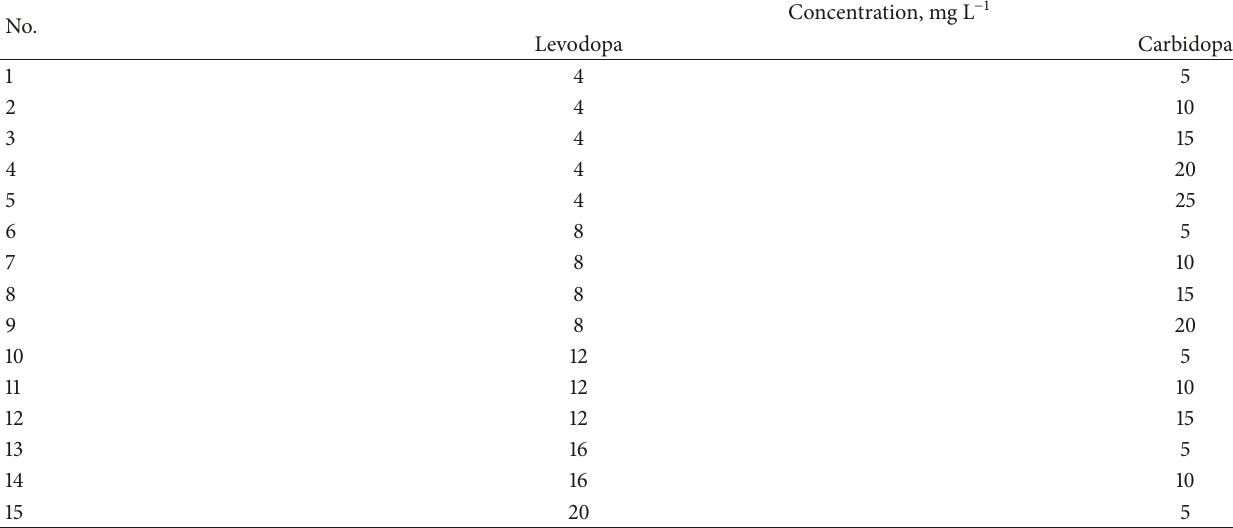
Table 1: Concentration set for levodopa and carbidopa.